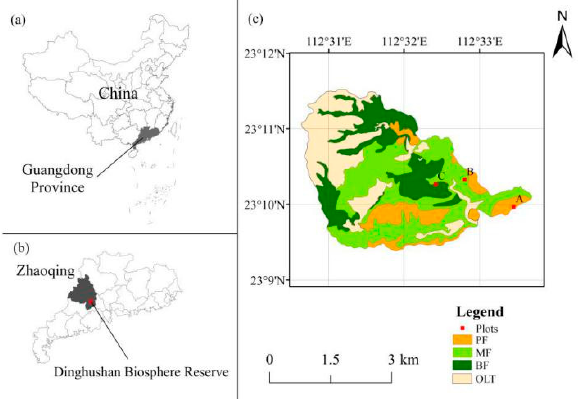
Figure 1. Location of the experimental sites in Dinghushan Biosphere Reserve ( c ), Zhaoqing ( b ), Guangdong, China ( a ). Abbreviations: OLT, other land-use types; PF, Pinus massoniana forest; MF, mixed Pinus massoniana / broad-leaved forest; BF, monsoon evergreen broad-leaved forest. Table 1. Basic description of the study area.